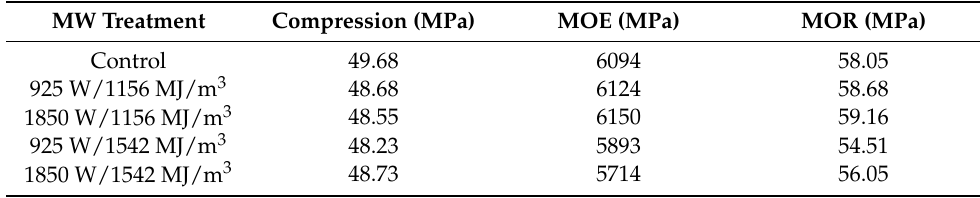
Table 13. Mechanical properties found by